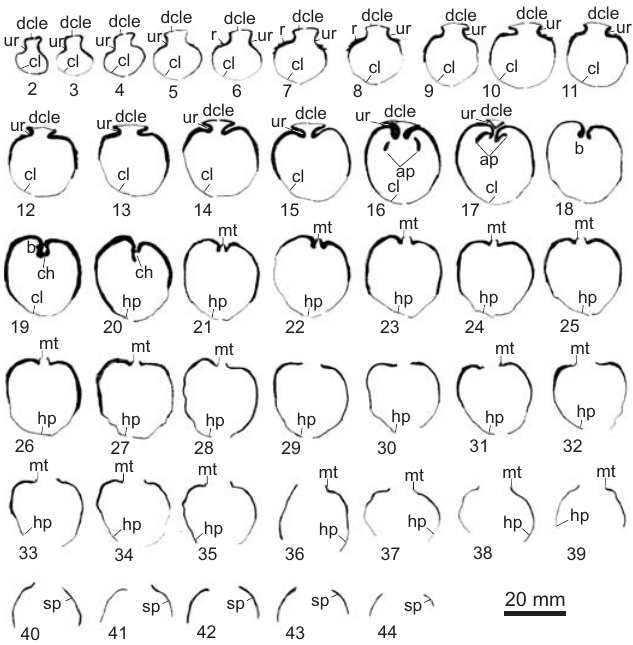
Fig. 7. Vertical transverse sections through pholadid bivalve Pholadidea gradzinskii sp. nov. (ZPAL Mo XVIII/12/A–W), preserved in life position within a boring from the Oligocene of King George Island. The